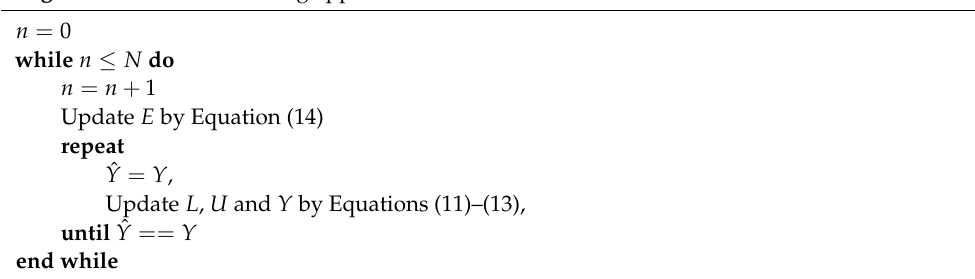
Algorithm 2. The fast-linking